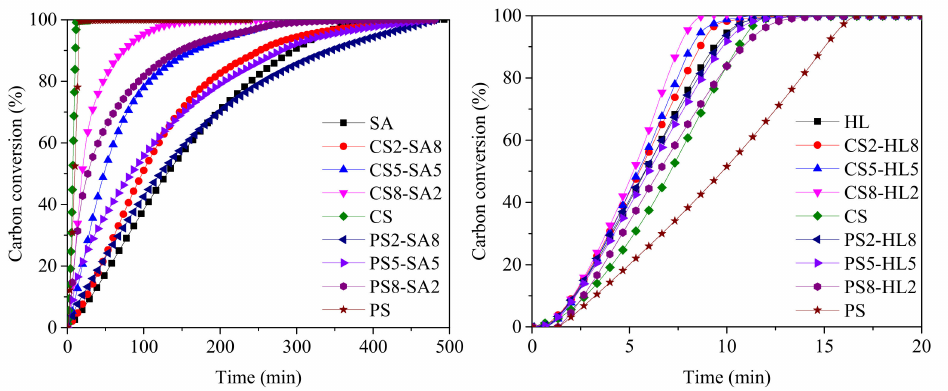
Figure 6. Carbon conversion variations versus reaction time for different char samples.